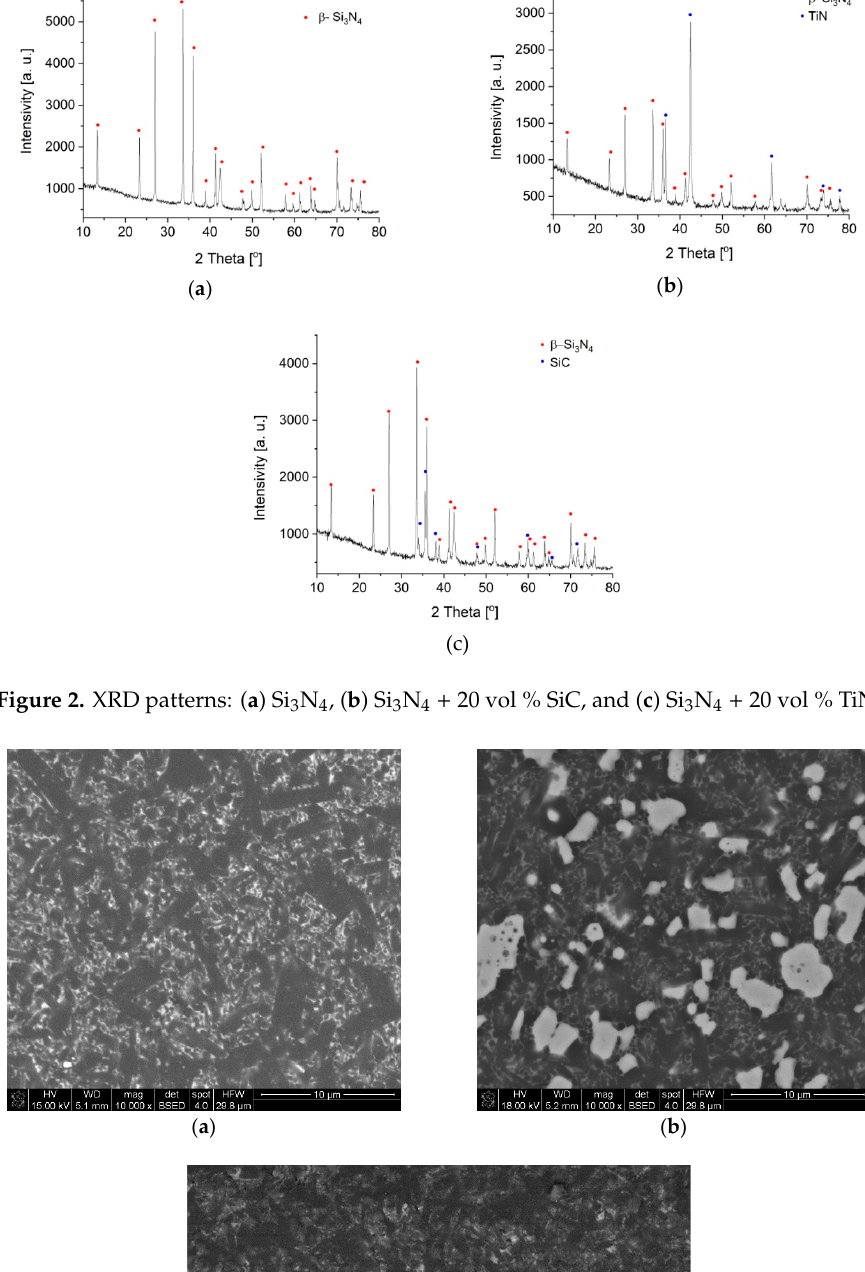
Materials 2019 , 12 , x FOR PEER REVIEW Figure 2. XRD patterns: ( a ) Si 3 N 4 , ( b ) Si 3 N 4 + 20 vol % SiC, and ( c ) Si 3 N 4 + 20 vol % TiN.